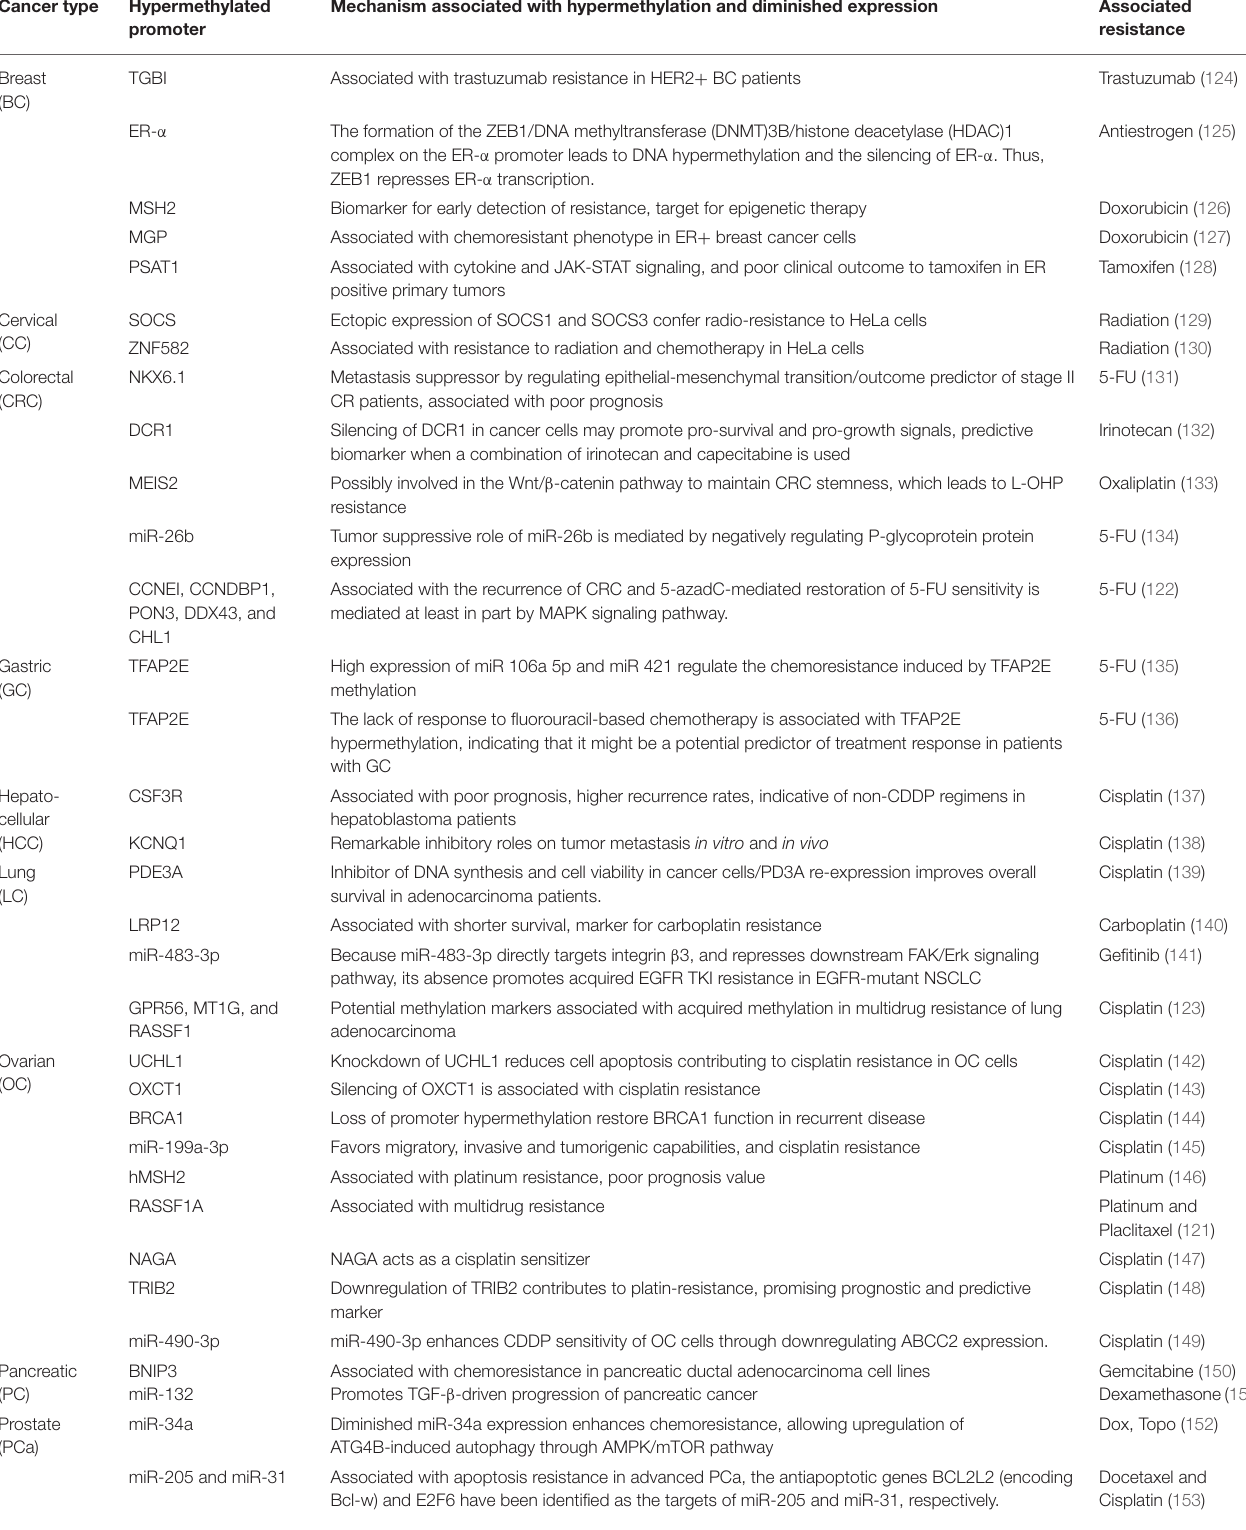
TABLE 3 | Hypermethylation associated with chemotherapy resistance in cancer. Cancer